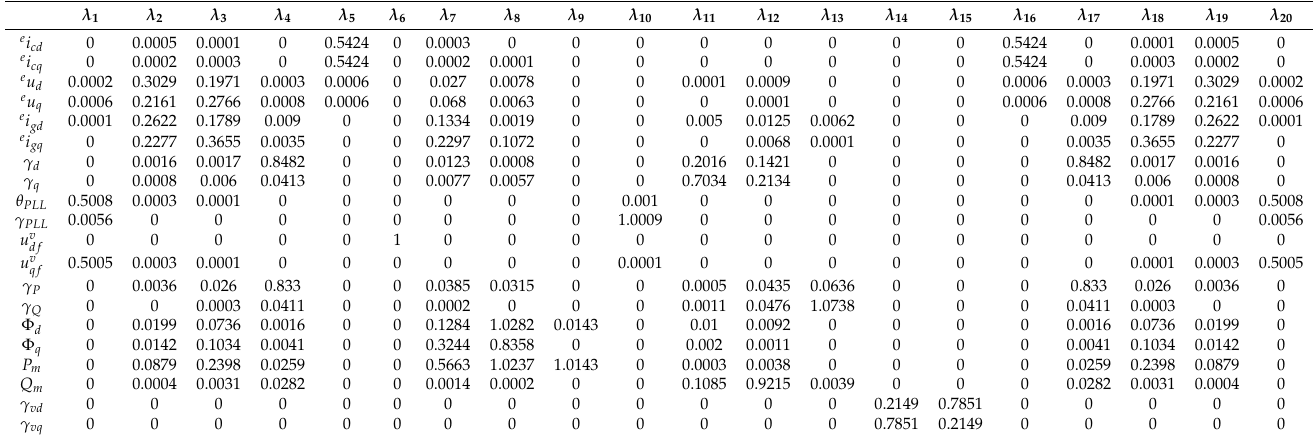
Table A1. Participation matrix for the